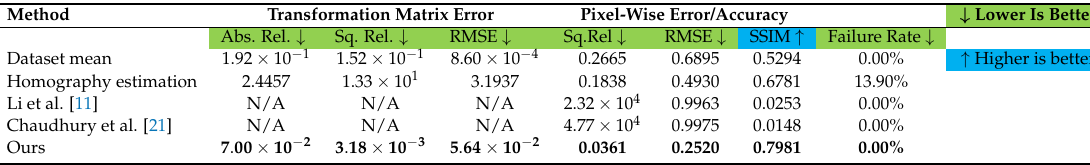
Table 2. Accuracy metrics. Best performance in